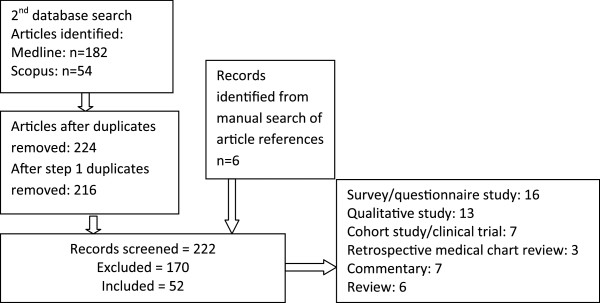
Search strategy two.